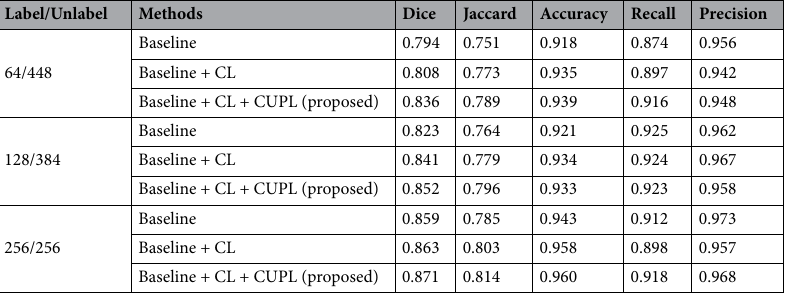
Table 3. Segmentation accuracy (Jaccard, Dice coefficient, Accuracy, Recall and Precision) comparison of CR and CUPL in our method on CVC-612 dataset.